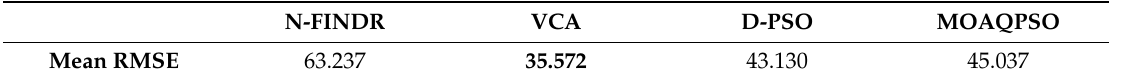
Table 8. Comparison between the simplex volumes obtained by N-FINDR, VCA, D-PSO, and MOAQPSO. N-FINDR VCA D-PSO MOAQPSO Volume Table 9. Comparison between the RMSEs of N-FINDR, VCA, D-PSO, and MOAQPSO. N-FINDR VCA D-PSO MOAQPSO Mean RMSE